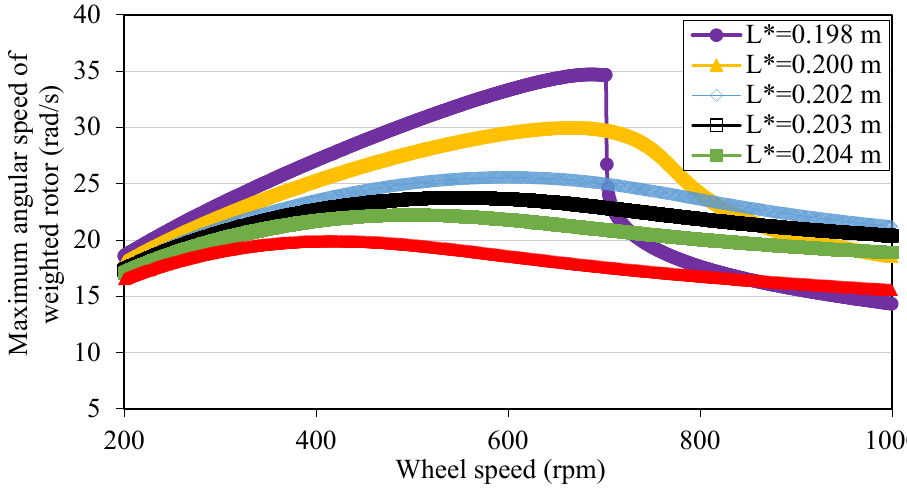
Figure 4. Variation of the steady-state maximum angular speed of WREH with various L * and wheel speed with C T * = 1.10 N·s·kg − 1 ·m − 1